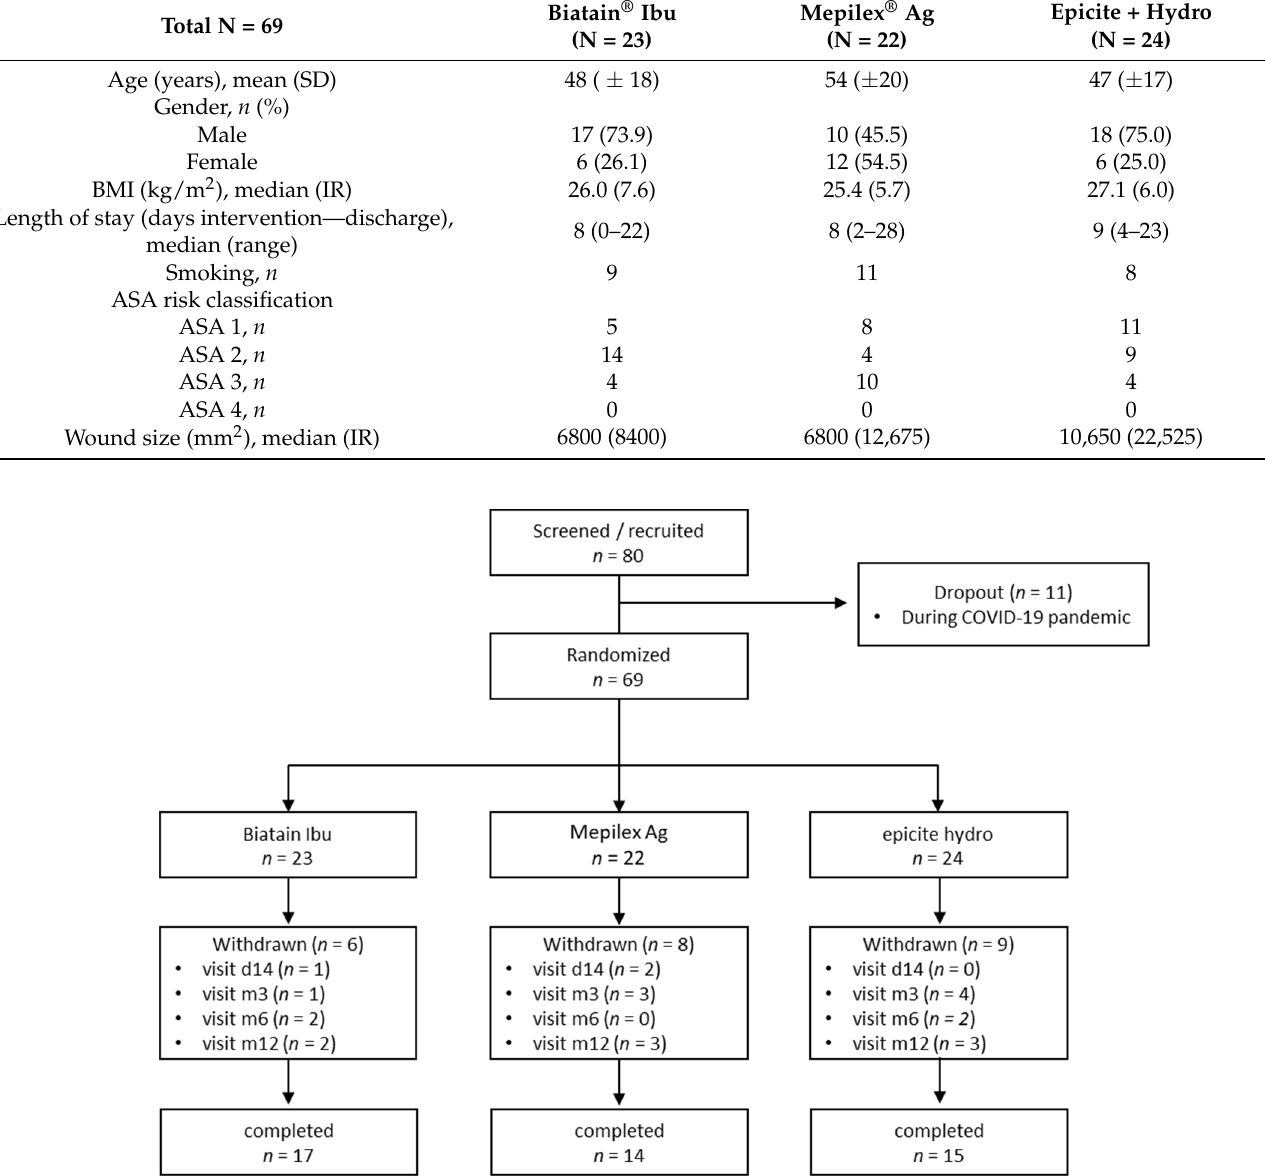
Figure 1. Flow of patients through the trial. d14, 14 days after dressing application; m3/m6/m12, 3/6/12 months following STSG donor site collection.